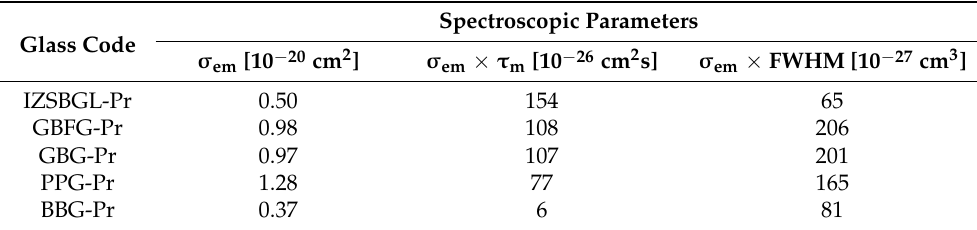
Table 6. Spectroscopic parameters for Pr 3+ ions in the studied inorganic glass